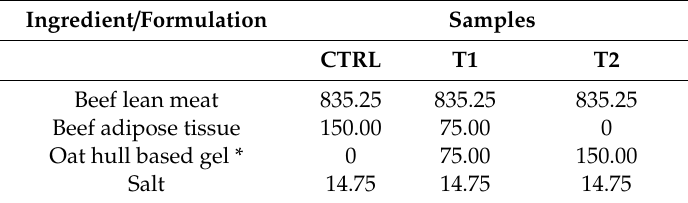
Table 1. Formulation (g kg − 1 ) of three di ff erent beef burgers without fat substitution (CTRL) and at 50% (T1) and 100% (T2) fat substitution. Ingredient /